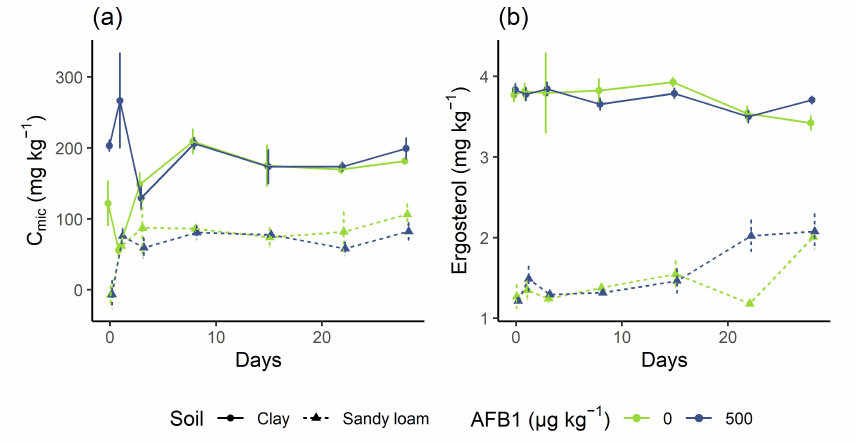
Figure 2. Microbial and fungal biomass responses to AFB1 exposure as a function of the incubation time. Curve plots showing the average values for microbial biomass carbon ( a ) and ergosterol as bioindicators for fungal biomass ( b ). The error bars represent the standard